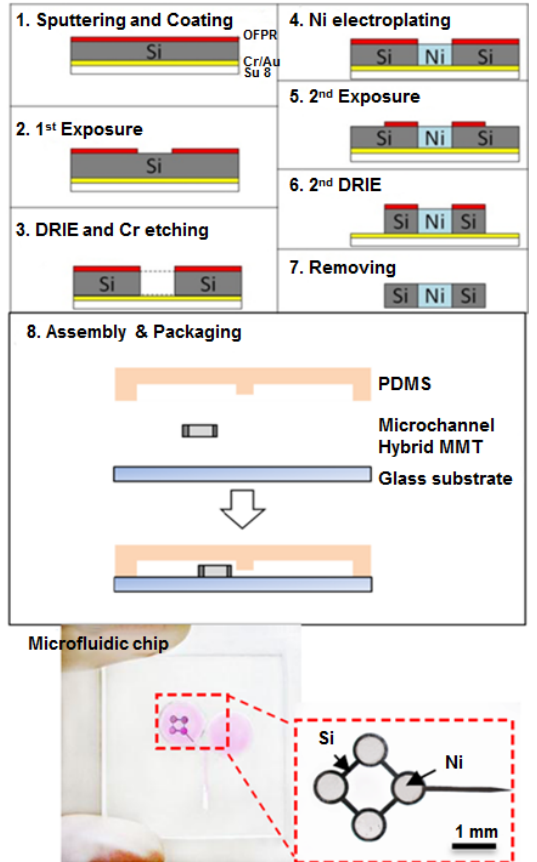
Figure 6. Fabrication process of the MMT and a fabricated chip with a magnified figure of the